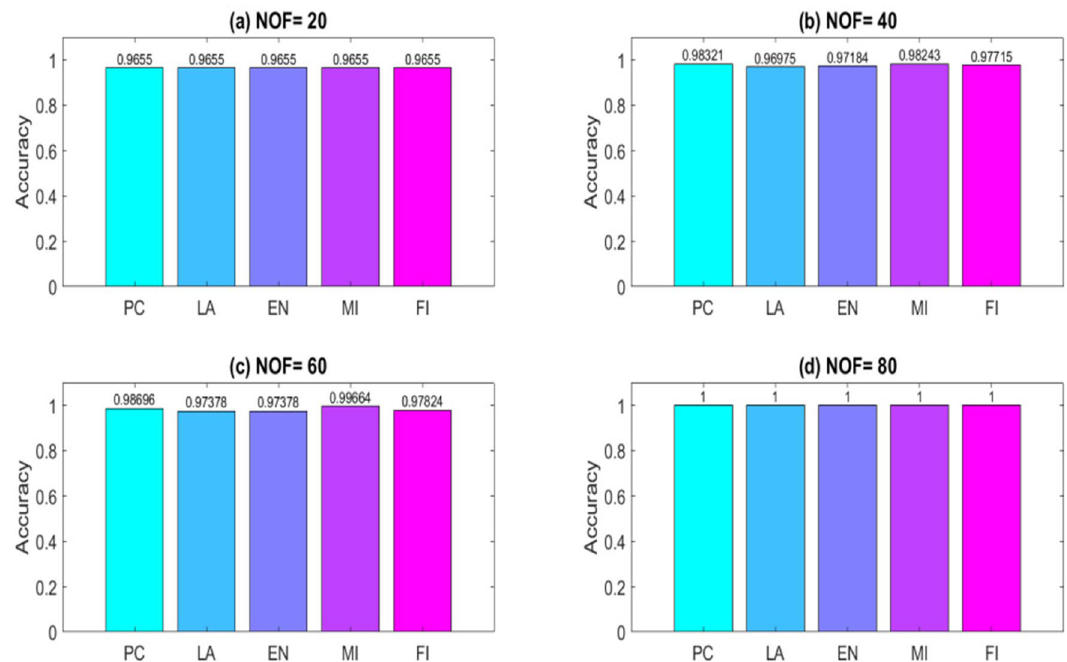
Figure 14. Outcomes of the filter FS methods on the Cancer dataset with selecting ( a ) 20, ( b ) 40, ( c ) 60, and ( d ) 80 features. When the number of features (NOF) is confined to 80, all the ways acquire the best possible solution. PC, Pearson correlation; LA, Laplacian score; EN, entropy; MI, mutual information; FI, Fisher score.